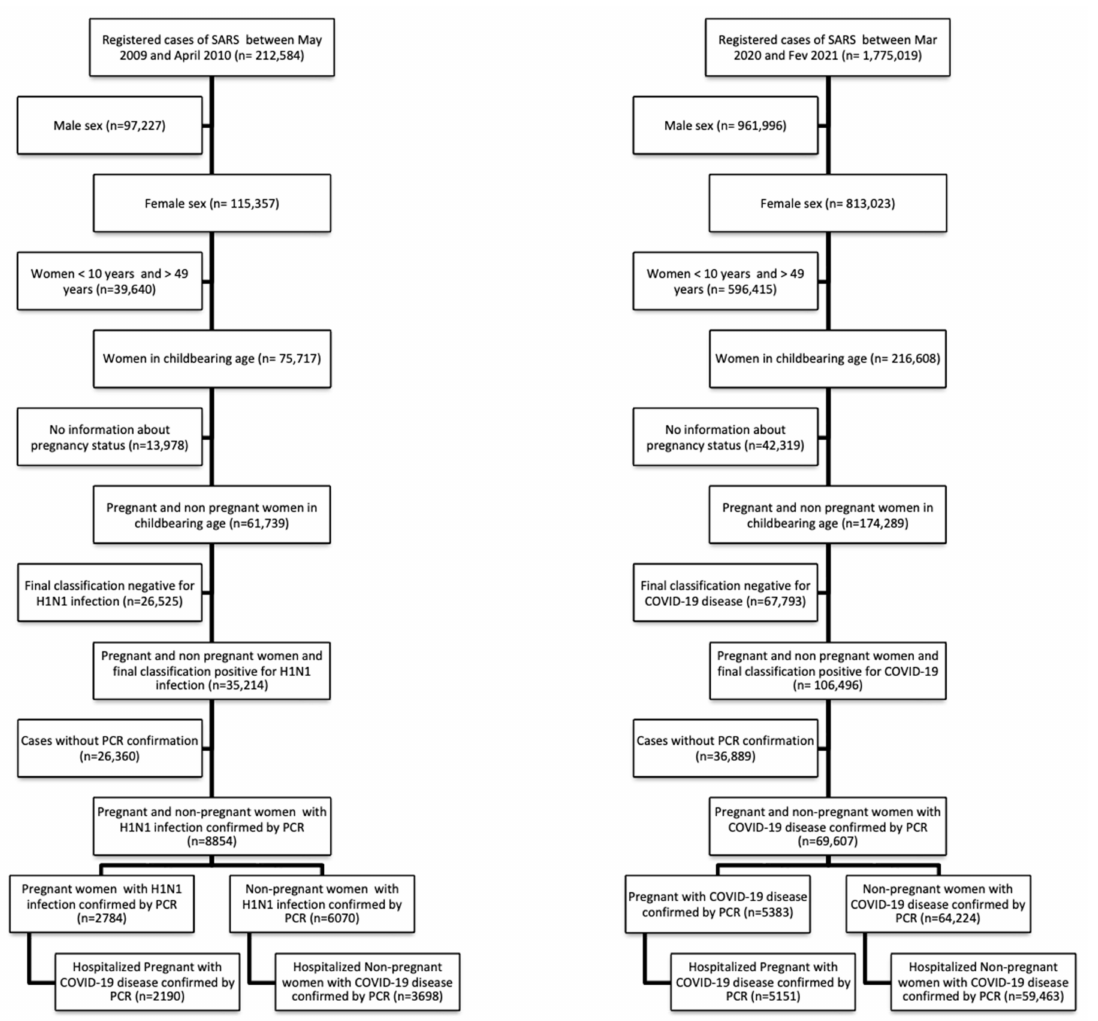
Figure 1. Selection of subjects included in the analysis for both H1N1 and COVID-19 pandemics in